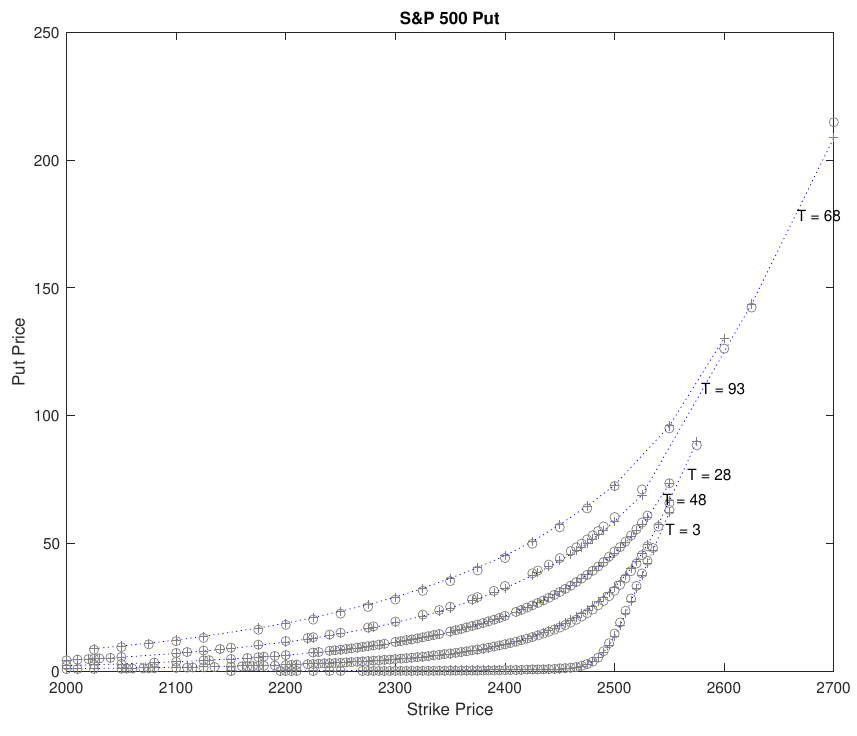
Figure 3. Observed SPX option price and model prices calibrated to the market prices for Call (top) and put (bottom) on September 11, 2017. ‘ ◦ ’ stands for the market price and ‘+’ stands for the FFT